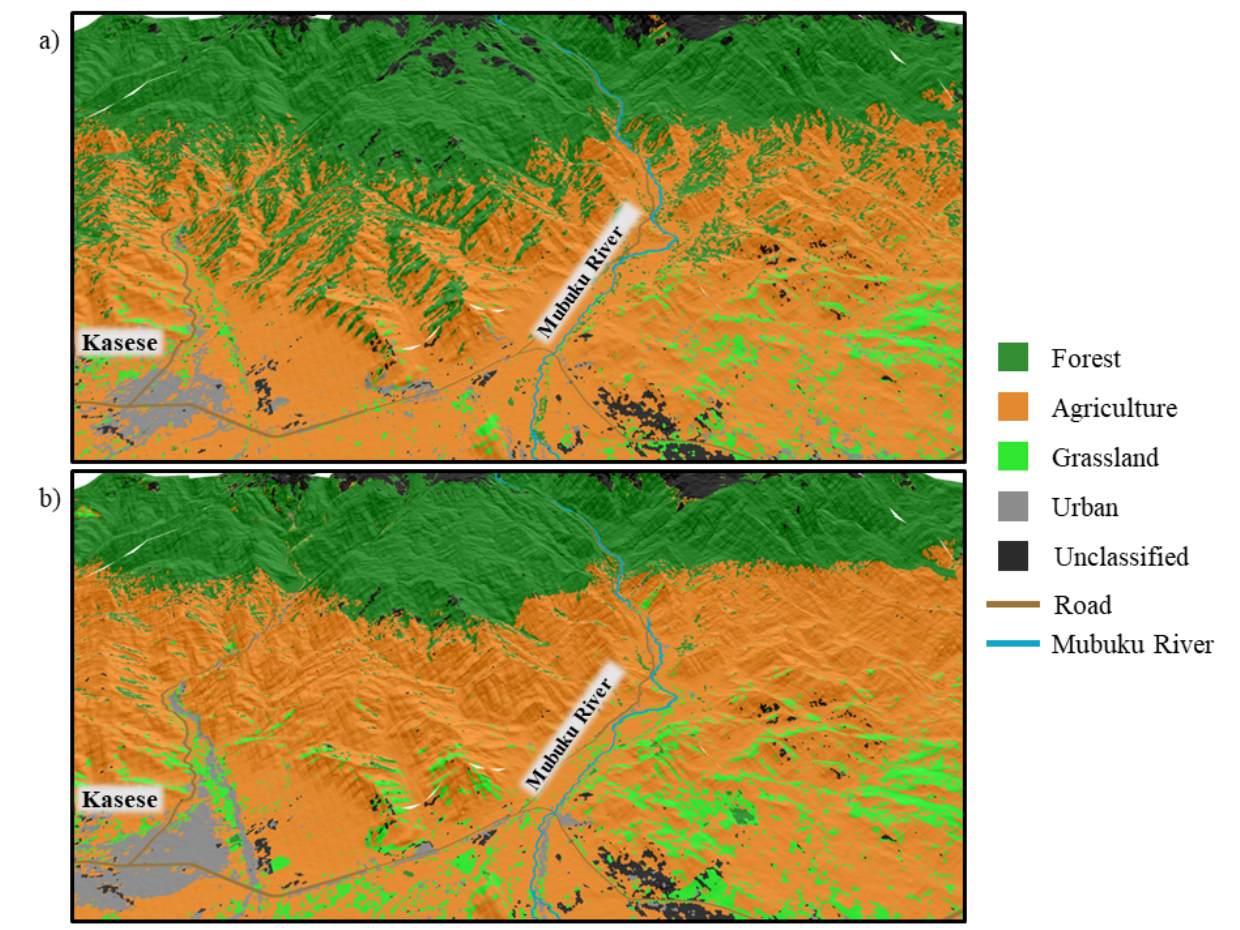
Figure A2. Spatial and temporal patterns of land cover change in Rwenzori Park and a 10 km buffer zone: Landsat images of 1987 ( a ) and 2015 ( b ).